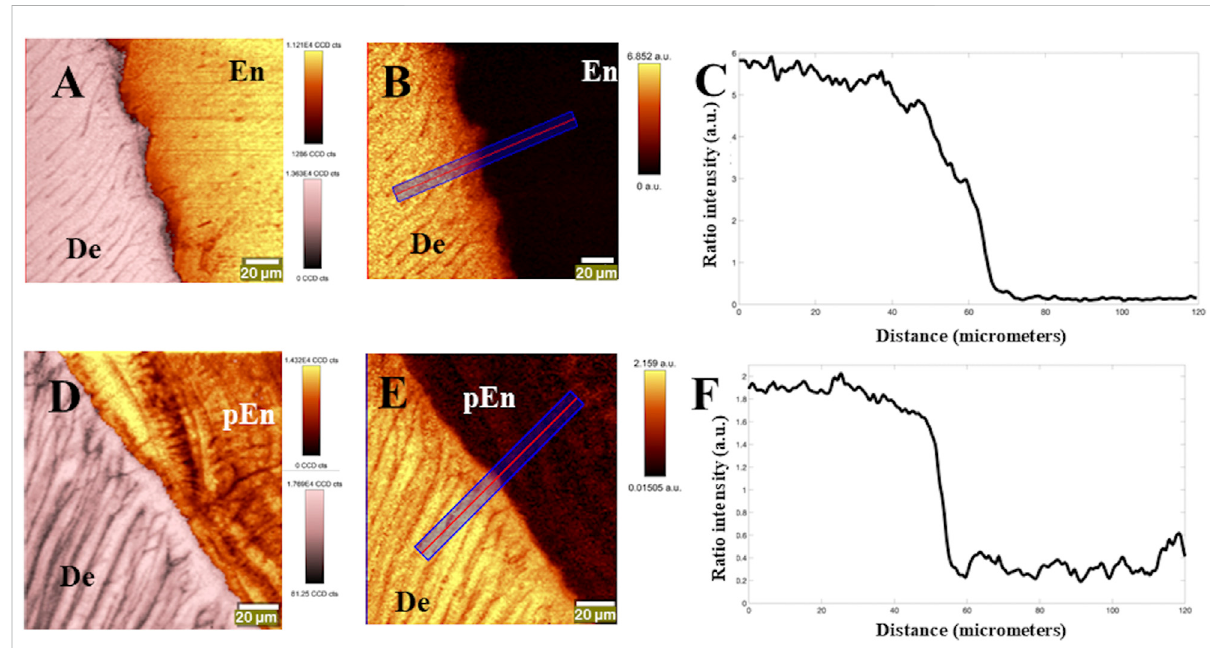
FIGURE 3 Reconstructed images of control (adult) and ERS1 teeth at the DEJ area. For the conversion in CCDs please use the corresponding lookup tables: (A – C) controlpermanenttooth. (A) Chemicalcombinedimageofphosphate/960 cm − 1 peak(yellowhue)intensityandC-H/2,800 cm − 1 peak (pinkhue)intensityattheDEJ; (B) RatioimageofCH/2,800 cm − 1 peakintensitydividedbyphosphatepeakintensityat960 cm − 1 ; (C) plottedpro fi leof ratio at the DEJ, along the blue line in (B) . (D – F) ERS permanent tooth. (D) Combined mage of phosphate/960 cm − 1 peak (yellow hue) and CH/ 2,800 cm − 1 peak(pinkhue)intensitiesforERS1tooth; (E) RatioimageofCH/2,800 cm − 1 peakintensitydividedbyphosphate/960 cm − 1 peakintensity. (F) plotted pro fi le of ratio at the DEJ, along the blue line in (E) . De, dentin; En, enamel; pEn, pseudo